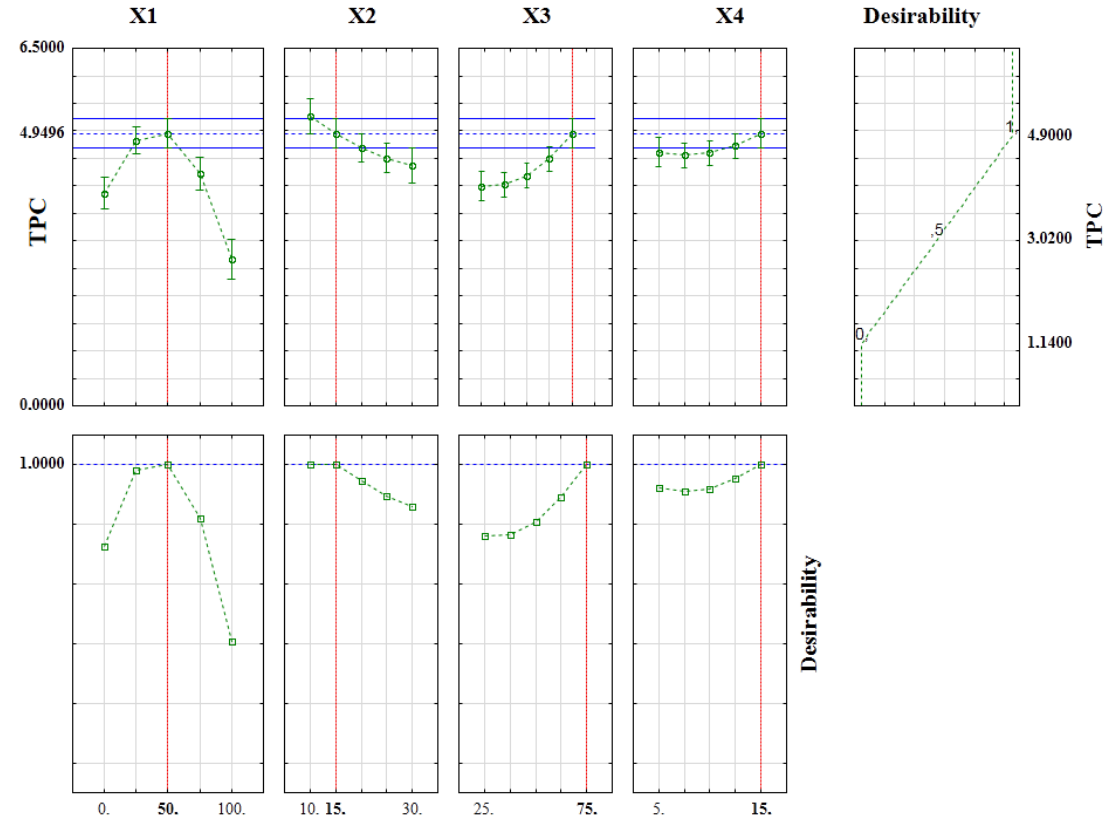
Figure 2. Profiles for predicted values and desirability function for the extraction of total phenolic content from kiwifruit pomace. Red lines indicate optimized values for each process parameter (X 1 = solvent composition, X 2 = solid-to-solvent ratio, X 3 = temperature, X 4 = extraction time).